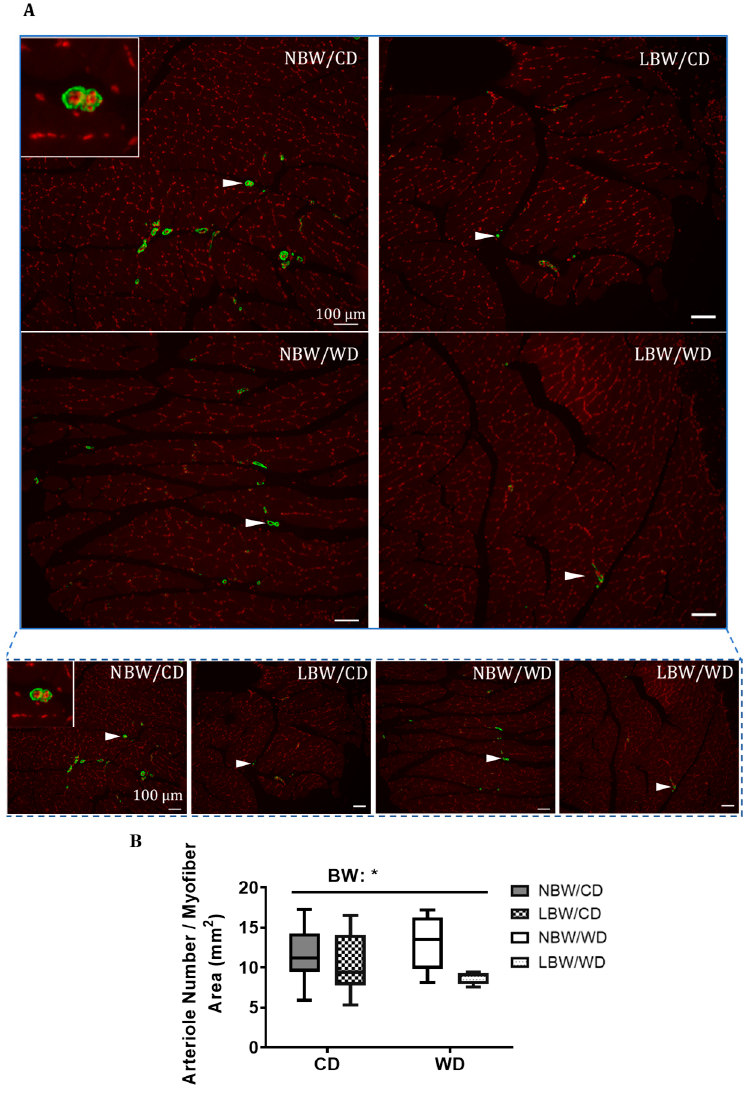
Figure 3. Microtome sections of smooth muscle α -actin ( α -SMA) immunoreactivity of muscle arte- rioles. Sections were immunostained for α -SMA (white arrowhead) to identify vascular smooth muscle cells in gastrocnemius from 145-day-old NBW and LBW guinea pig offspring fed a postnatal CD or WD. ( A ) Representative fields at high and low magnification and ( B ) arteriole num- ber/myofiber area are displayed. Data are presented as min. to max. box and whisker plots for 5–9 animals/experimental group. BW, birth weight; scale bar = 100 µ m. * p < 0.05 for the main effect of birth weight (BW) using a regular two-way